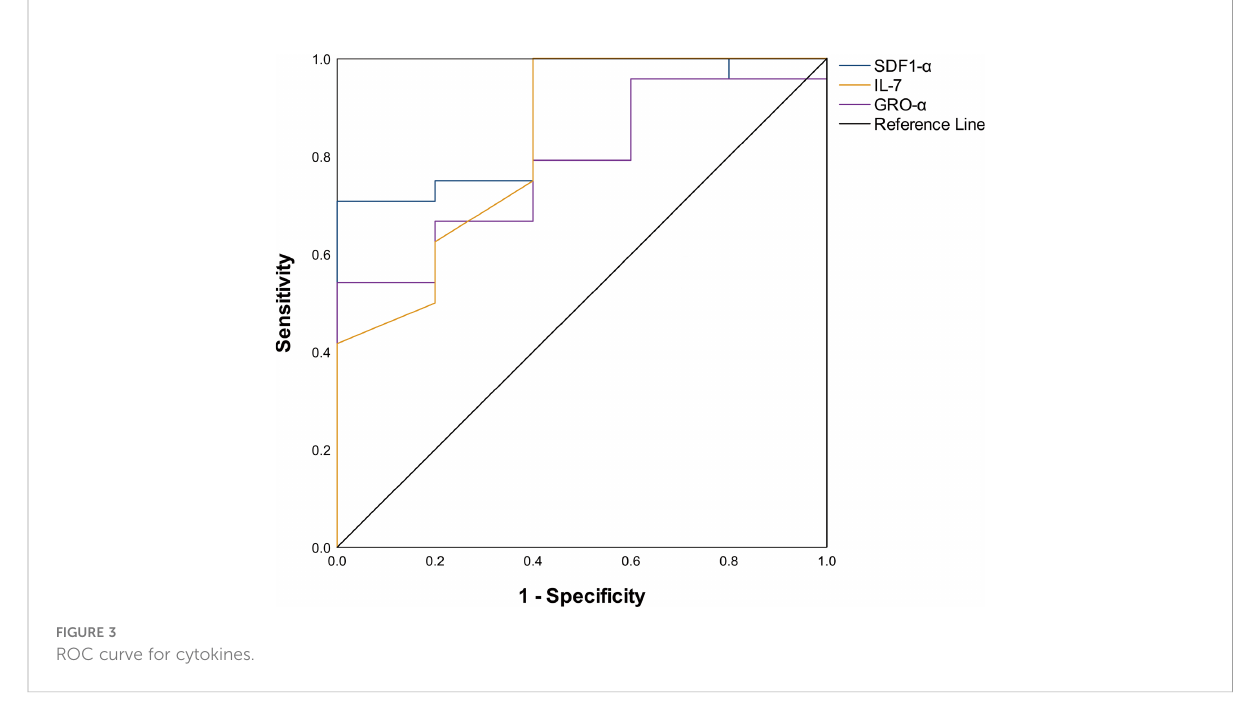
FIGURE 3 ROC curve for cytokines.